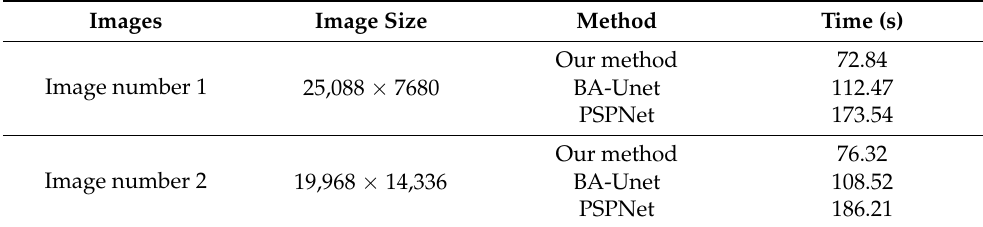
Table 7. Detection time of the two Sentinel-1 SAR images by using different deep learning methods.